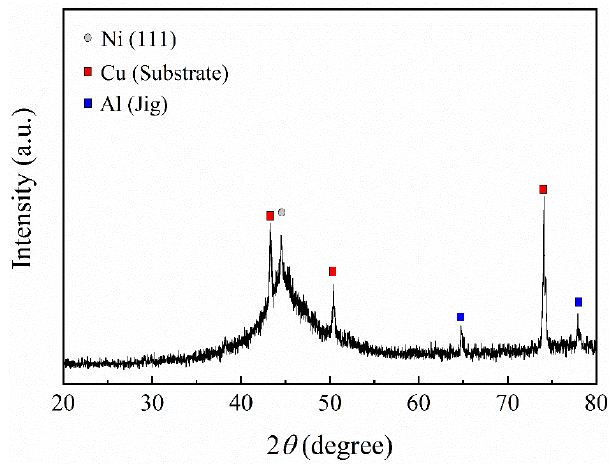
Figure 3. XRD diffraction pattern of electrodeposited Ni-13.4Cr-11.6P alloy coating.